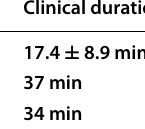
standard deviation) ±